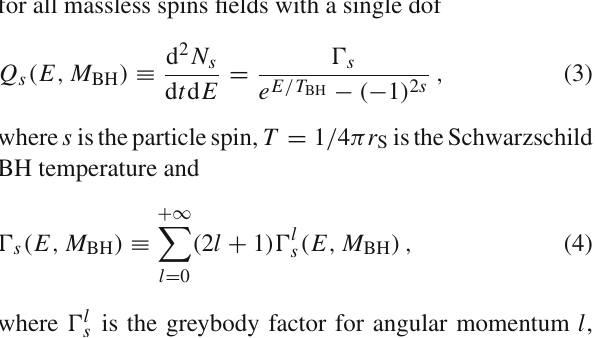
vertical line represents the BH temperature. These spectra are shape invariant when changing the BH mass. Right: High energy oscillations of the cross-section, the black horizontal line represents the geometrical optics